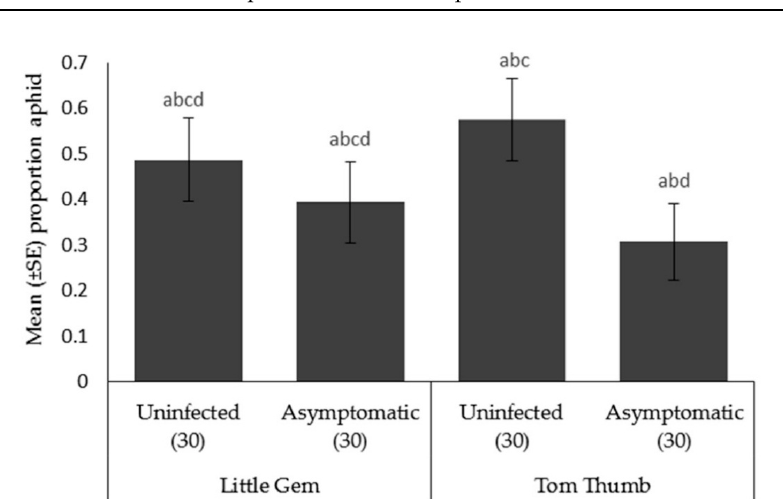
Figure 3. Mean ± SE proportion of aphids Myzus persicae orientating in an olfactometer trial towards two varieties (Little Gem, Tom Thumb) of uninfected or asymptomatically infected lettuce plants. Number of replicates per treatment is shown below each bar; treatments sharing the same letters above each bar are not significantly different at p < 0.05 following post-hoc tests.